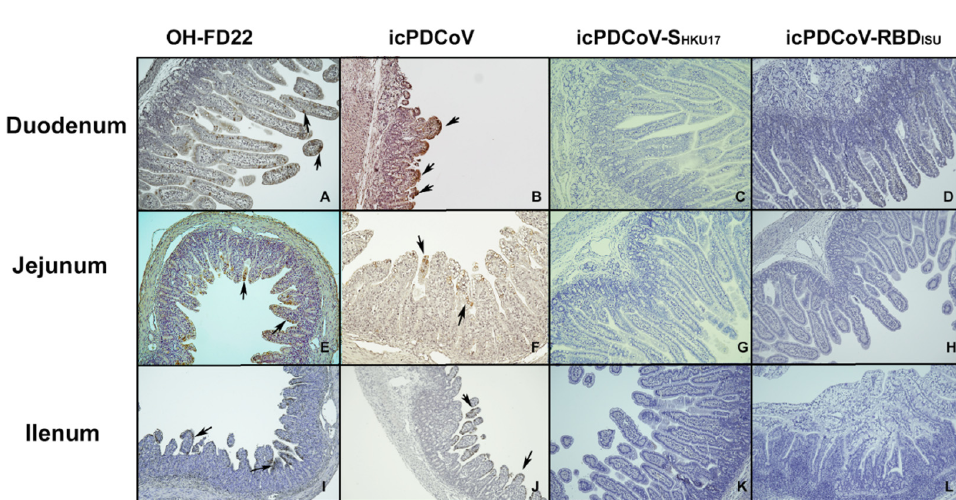
Figure 6. Immunohistochemistry staining of PDCoV N proteins in the enterocytes of duodenum, jejunum, and ileum of piglets inoculated with OH-FD22 ( A , E , I ), icPDCoV ( B , F , J ), icPDCoV-S HKU17 ( C , G , K ), or icPDCoV-RBD ISU ( D , H , L ) (magnification, 100 × ). The brown signals, indicated by